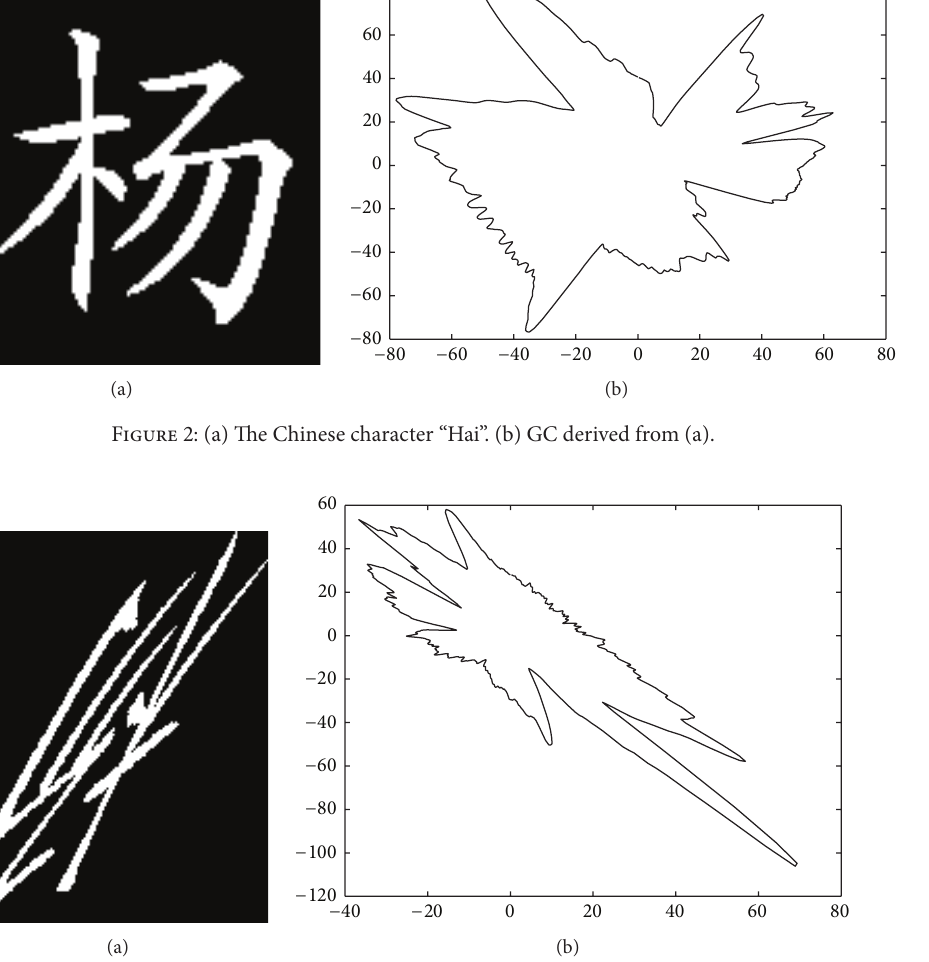
𝑏 1 ) ∈ R 2 and A = ( 𝑎 11 𝑎 12 where b = ( 𝑏 2 nonsingular matrix with real